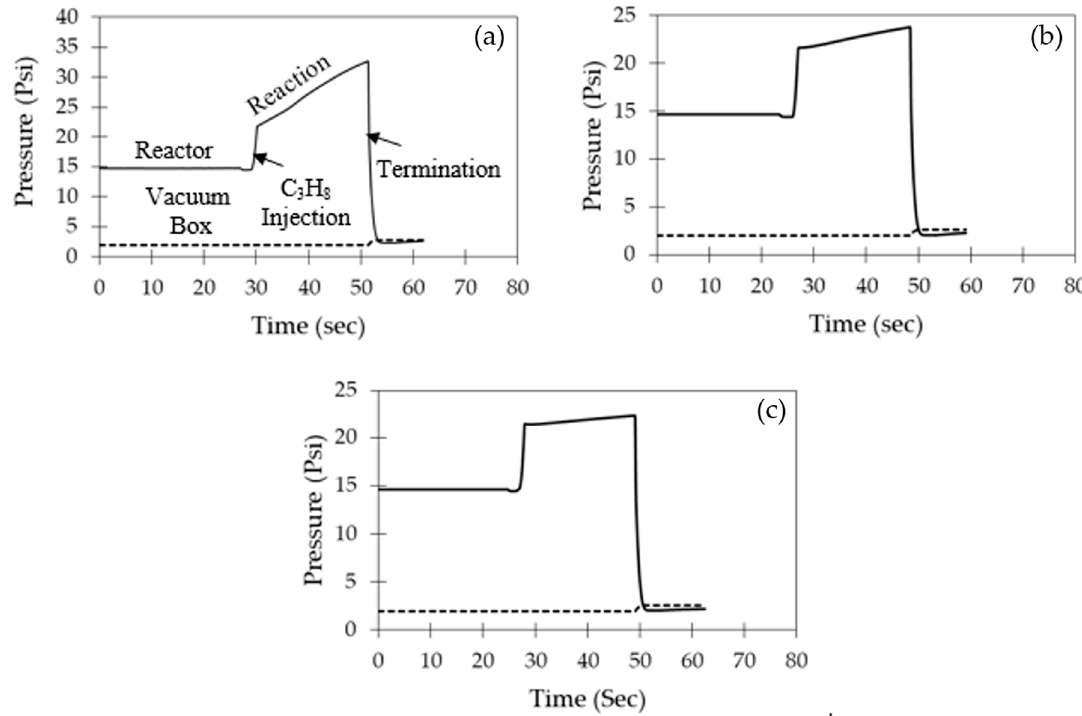
Figure 4. Pressure profile in the CREC Riser Simulator for consecutive propane ODH reaction. ( a ) After 1st injection; ( b ) After 2nd injection; and, ( c ) After 10th injection.